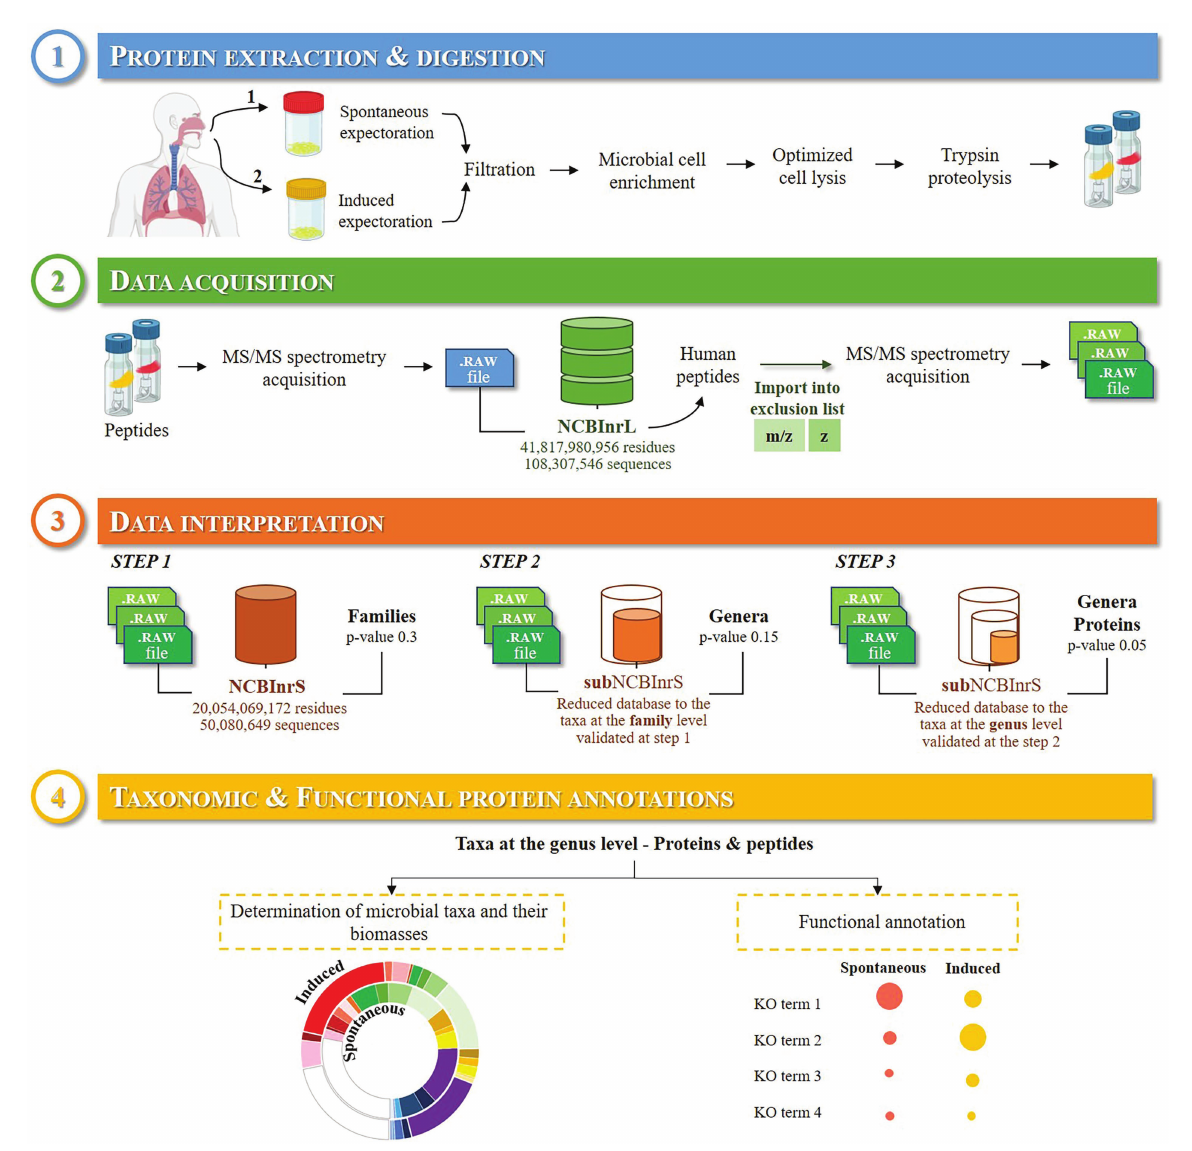
FIGURE 1 Experimental workflow of the study. ① Paired spontaneous and induced sputum samples collected from CF patients were filtered to reduce their viscosity and submitted to differential centrifugation to concentrate the microorganisms. The proteins extracted were submitted to a short in-gel migration and digested into peptides using trypsin. ② The resulting peptides were analyzed by nanoLC-MS/MS. ③ Results were interpreted in a three-step cascaded search to retrieve the taxonomic and functional protein annotations ④